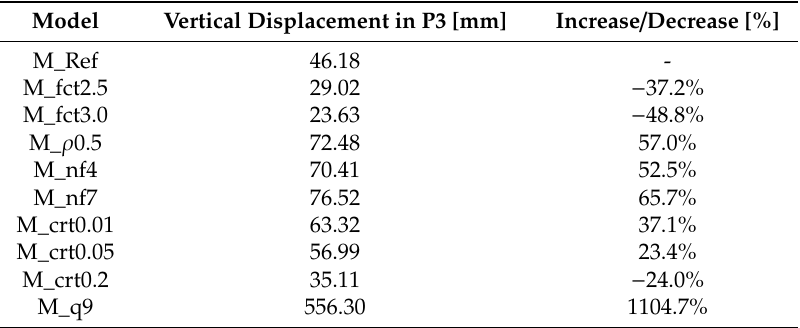
Table 5. Percentage increase / decrease in maximum residual vertical displacements.